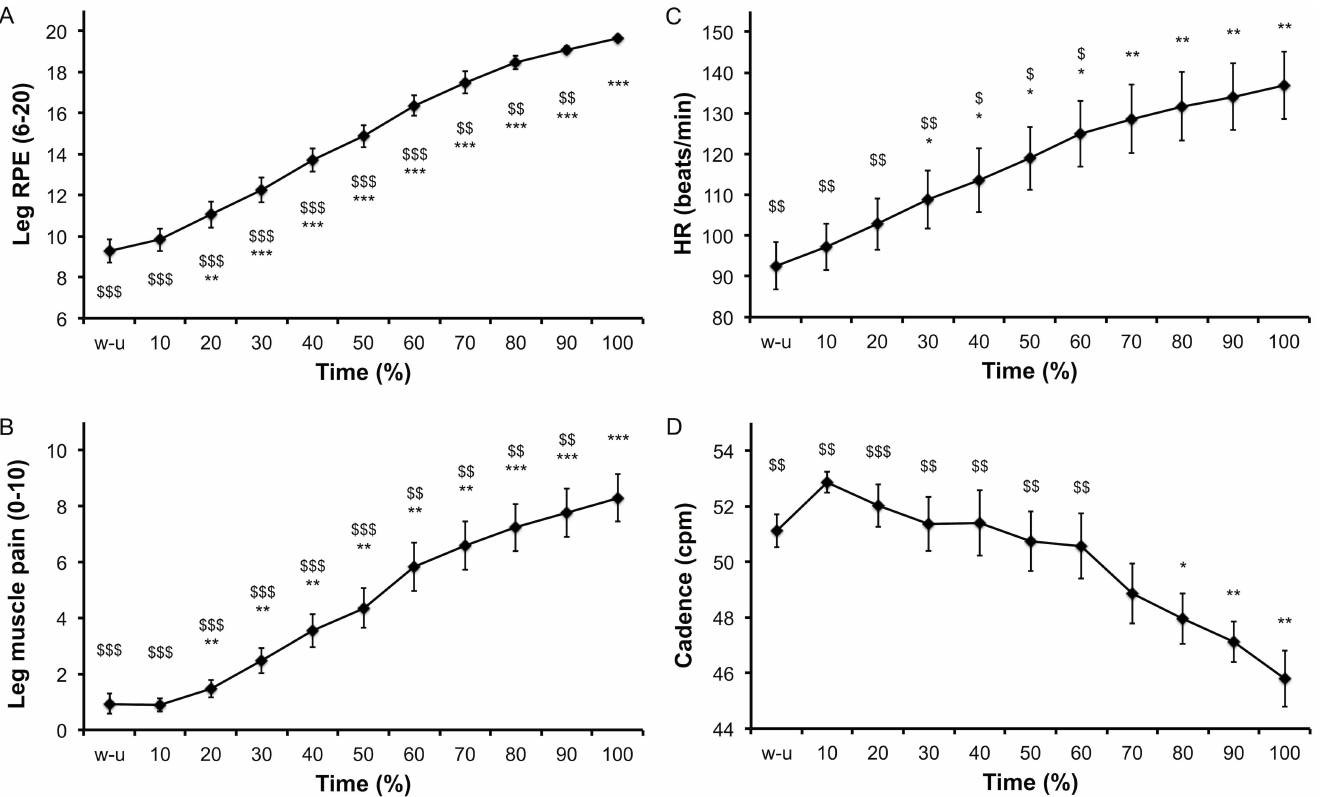
Fig 4. Time course of perceptual responses (panel A and B), heart rate (panel C) and cadence (panel D) during the time to exhaustion tests. Data are presented as main effect of time and mean (SE). * significantly different from 10% and $ significantly different from 100%, 1 item for P < 0.05, 2 items for P < 0.01 and 3 items for P <